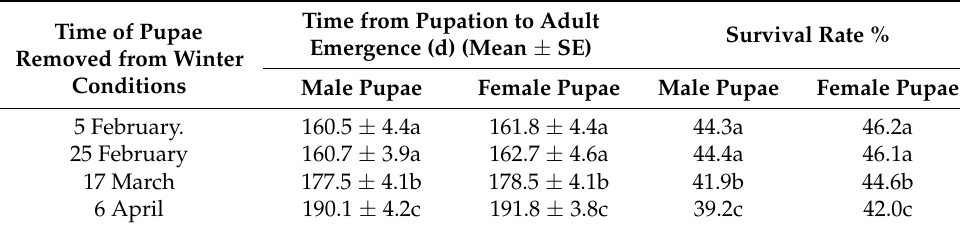
Table 1. Effect of time variation of moving from natural environmental conditions to incubator heating on the time from pupation to adult emergence and survival rate of pupae. Time from Pupation to Adult Time of Pupae Survival Rate % Emergence (d) (Mean ± SE) Removed from Winter Conditions Male Pupae Female Pupae Male Pupae Female Pupae 5 February. 160.5 ± 4.4a 161.8 ± 4.4a 44.3a 46.2a 25 February 160.7 ± 3.9a 162.7 ± 4.6a 17 March 177.5 ± 4.1b 42.0c Different letters in the same column indicate significant differences between treatment groups ( p < 0.05). After diapausing pupae were moved from outdoors to the incubator and warmed, the time required for adult emergence decreased in a polynomial pattern (female: y = 0.0067x 2 − 589.7x, R 2 = 0.8523, p < 0.01; male: y = 0.0088x 2 − 783.41x, R 2 = 0.8501, p < 0.01, Figure 4). The time required for female and male emergence in the 5 February treatment group was 44.6 ± 5.3 d and 43.8 ± 5.3 d, respectively, shortening to 23.7 ± 4.6 d and 21.7 ± 3.9 d, respectively, by 25 February, 19.5 ± 4.2 d and 18.5 ± 4.2 d, respectively, by 17 March and only 12.9 ± 3.8 d and 13.1 ± 4.8 d by 5 April.